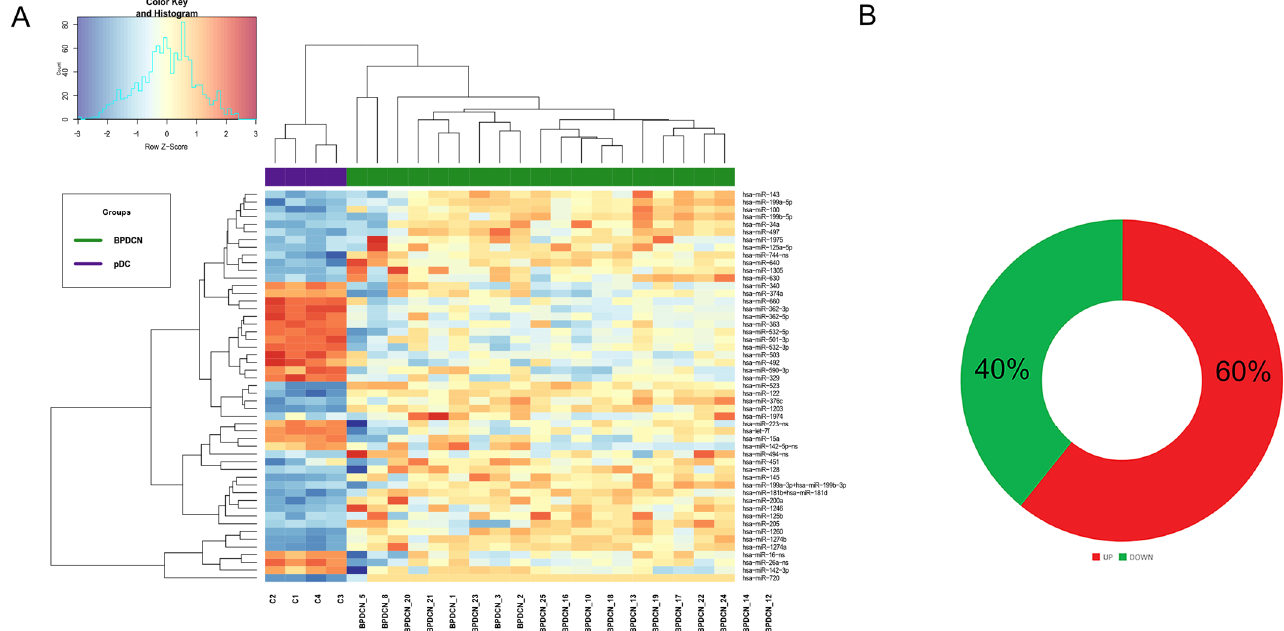
Figure 1. MicroRNA expression profiling of in blastic plasmacytoid dendritic cell neoplasm (BPDCN). ( A ) Heat map of genes differentially expressed in BPDCNs vs. plasmacytoid dendritic cells (pDCs), according to differential expression analysis. Tumor BPDCN samples are reported in green and pDC control samples in purple; ( B ) MiRNAs upregulated and downregulated are graphically represented by a donut chart.